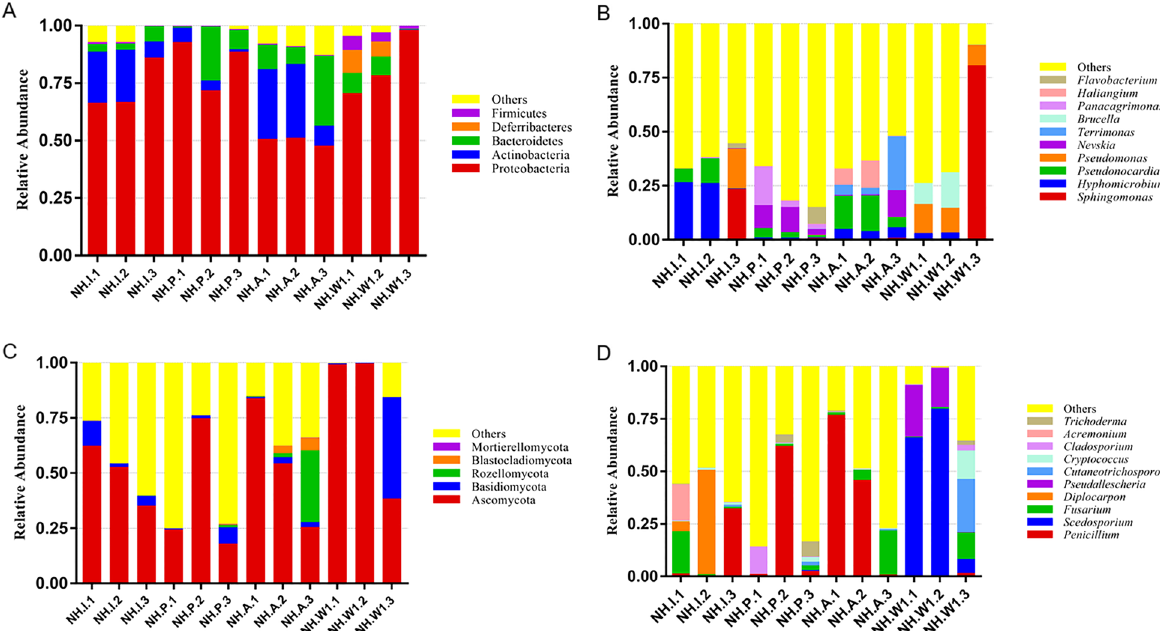
Fig. 2 The relative abundance of microbial communities in four kinds of maritime cultural relic immersion water samples. The relative abundance is shown as a percentage. Phylum and genera are colored according to the legend on the right. A Relative abundance of bacteria in water samples at the phylum level. B Relative abundance of bacteria in water samples at the genera level. C Relative abundance of fungi in water samples at the phylum level. D Relative abundance of fungi in water samples at the genera